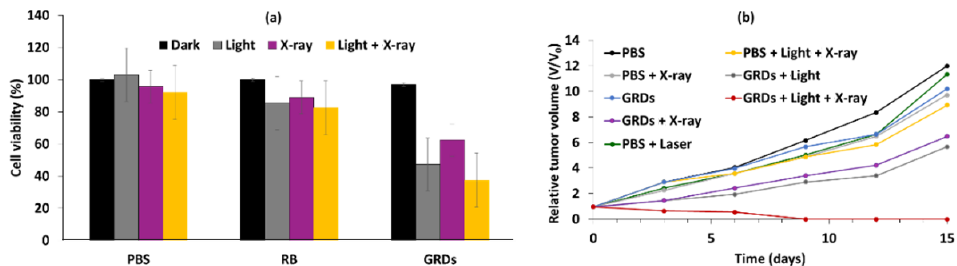
Figure 43. ( a ) Cell viability of 4T1 cells incubated for 24 h with PBS, RB and GRDs (4.0 µg/mL) in the dark or following laser and/or X-ray irradiation (laser: 532 nm, 30 mW/cm 2 , 5 min; and X-ray: 1 Gy). ( b ) Relative tumor volume under different treatment conditions (10 mg/kg). (Laser: 532 nm, 140 mW/cm 2 , 15 min; X-ray: 1Gy). Adapted from Sun et al. [110].